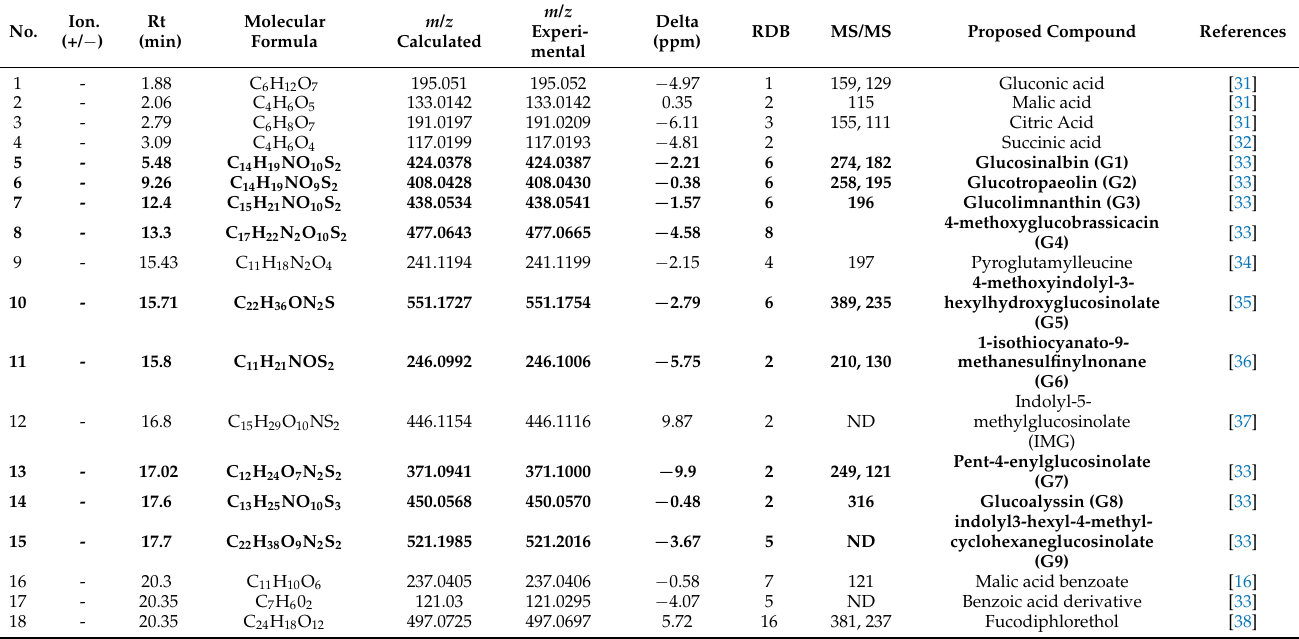
Figure 1. General structure of glucosinolates, the group R is variable. The applied chromatographic conditions allowed for the determination of twenty metabolites in the extracts of L. peruvianum that were visible in the negative ionization mode (also see Figures S1 and S2 in the Supplementary File), as presented in Table 1. The identification was based on high-resolution molecular weight measurements, analysis of their MS/MS spectra, retention times, open MS databases, and scientific literature and is in line with the previously published data of other researchers [14,26,30]. The total ion chromatogram (see Figure S3 in Supplementary File) of the selected extract, the extracted ion chromatograms of all glucosinolates whose presence was confirmed in the negative mode [26], and the MS/MS spectra of the tentatively identified structures are presented in Table S1 in the Supplementary File. Table 1. The composition of the 50% EtOH ( v / v ) extract from tubers of black A variety of Lepidium peruvianum recorded in the negative ionization mode. (RDB—rings and double bond number, delta—error of mass measurement, ion—ionization mode: positive or negative, ND—not detected). Compounds depicted in bold were subjects of chemometric